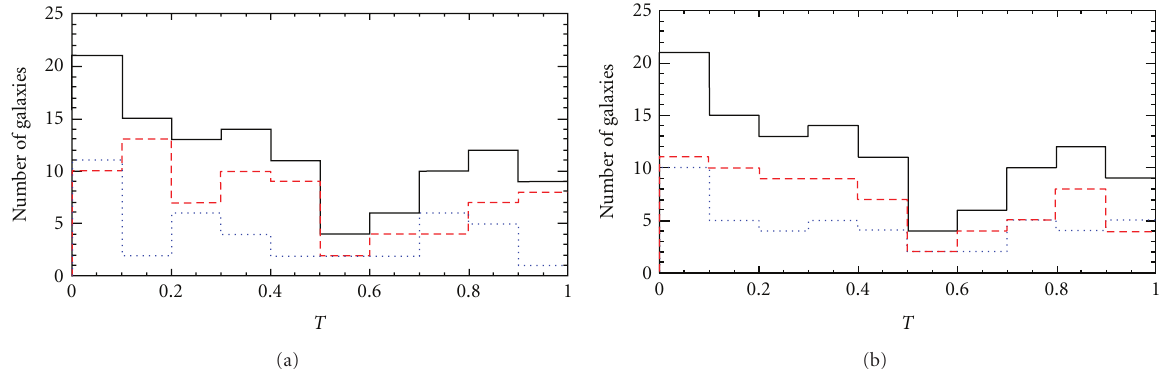
Figure 10: Distribution of the triaxiality parameter T for the 115 bulges of S0 and early-type galaxies. Values of T = 0 indicate oblate bulges and T = 1 prolate ones. The distributions of T for bulges with n < 2 (dotted line) and n > 2 (dashed line) are shown in (a). (b) shows the T distributions for bulges of galaxies with B/T < 0 . 3 (dotted line) and B/T > 0 . 3 (dashed line). See [104] for more